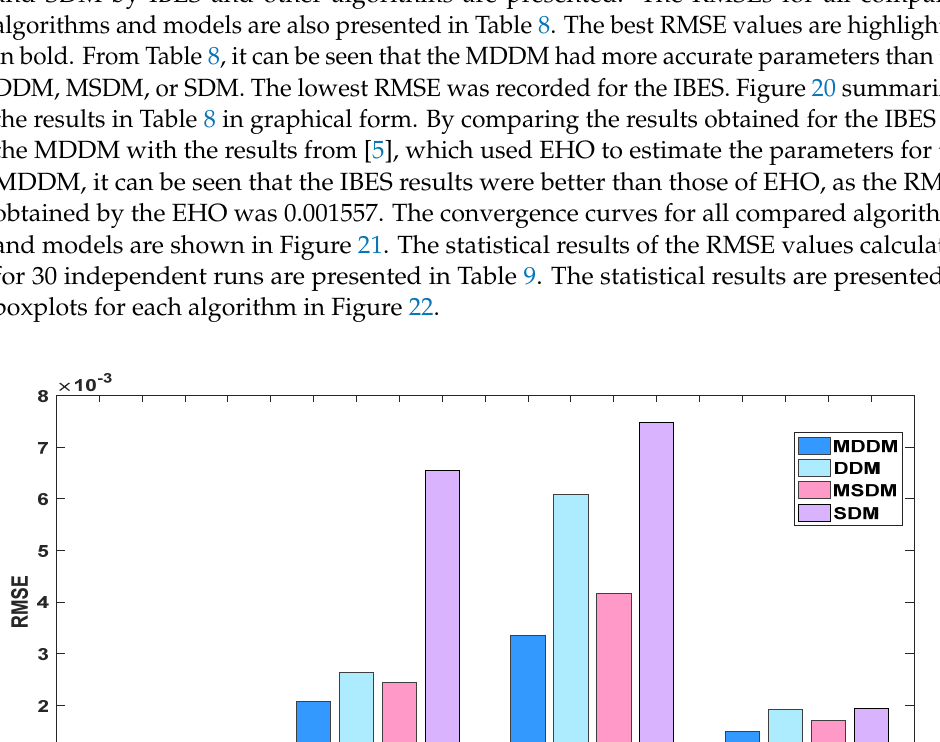
Figure 20. Comparison between the RMSE values of the IBES, GWO, MFO, and MRFO applied to the MDDM, DDM, MSDM, and SDM.